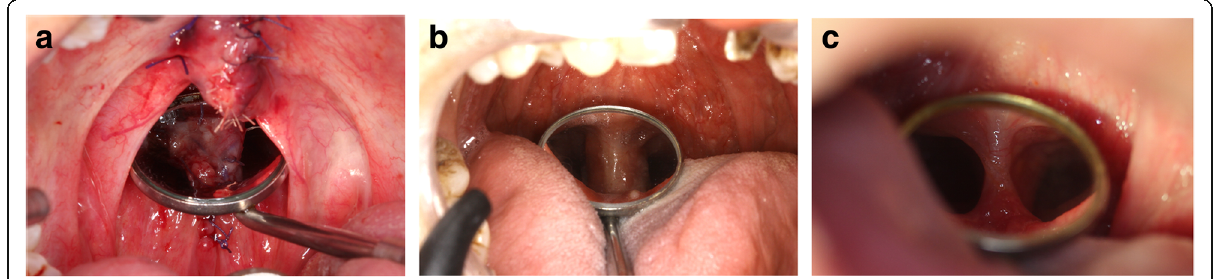
Fig. 2 Dimensional change of the pedicle of the posterior pharyngeal flap (case 2). a The pedicle reflected on the dental mirror during the operation. b Three months after the pharyngoplasty. c Six months after the